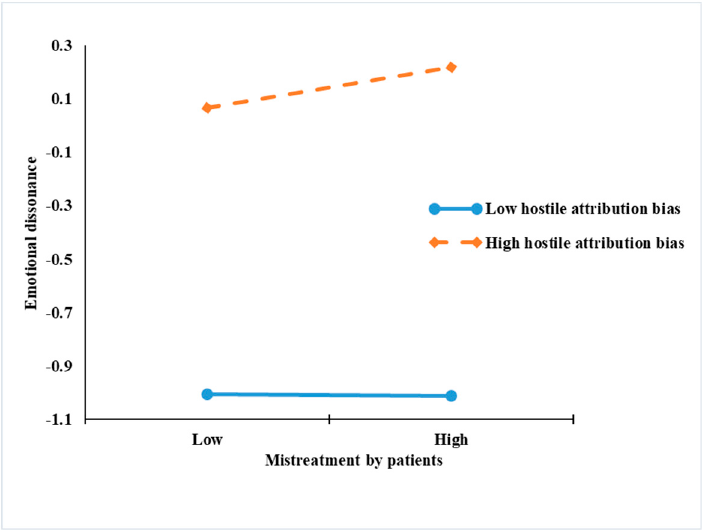
Figure 3. Interactive effects of mistreatment by patients and hostile attribution bias on emotional dissonance.